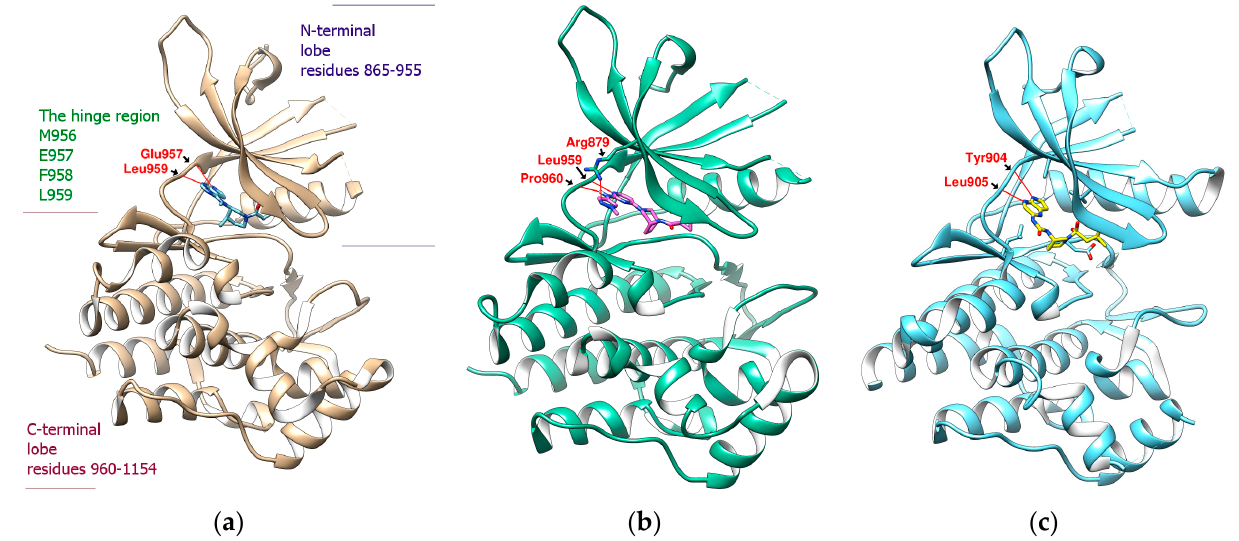
Figure 2. JAK inhibitor (ligand) and JAK complex. ( a ) Tofacitinib/PDB:3EYG(JAK1/2); ( b ) PF– 06700841/PDB:6DBN(JAK1); ( c ) 3C9/PDB:4QT1(JAK3). Hydrogen bonds were shown as red lines.